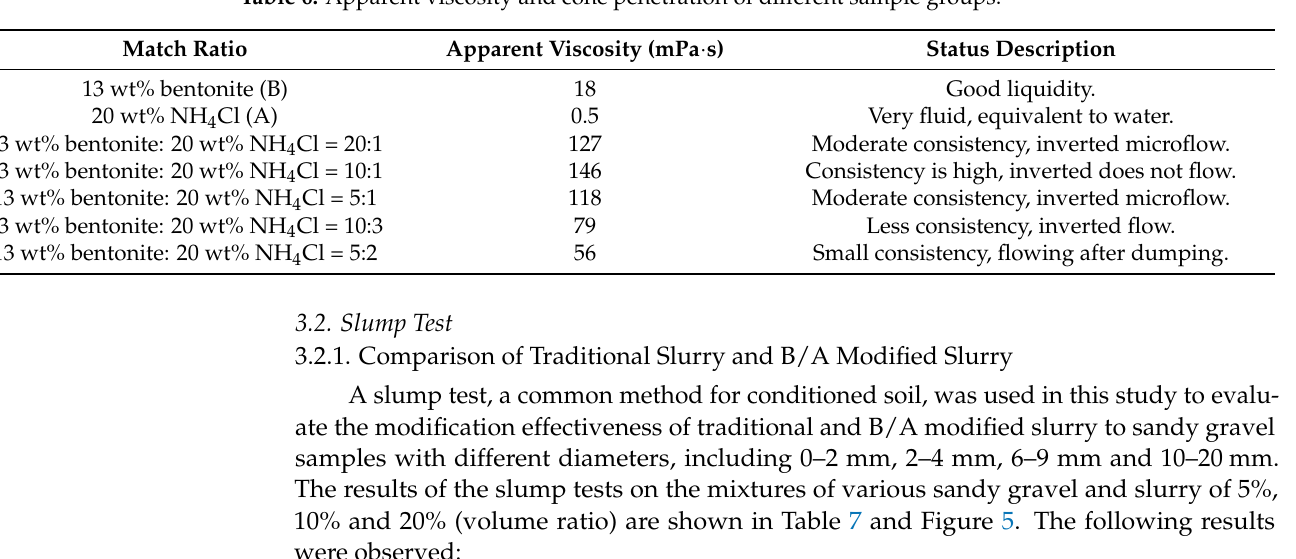
Figure 4. ( a ) Effect of the B/A modified slurry dumping state under different ratios, and ( b ) Change of apparent viscosity with time. Table 6. Apparent viscosity and cone penetration of different sample groups.